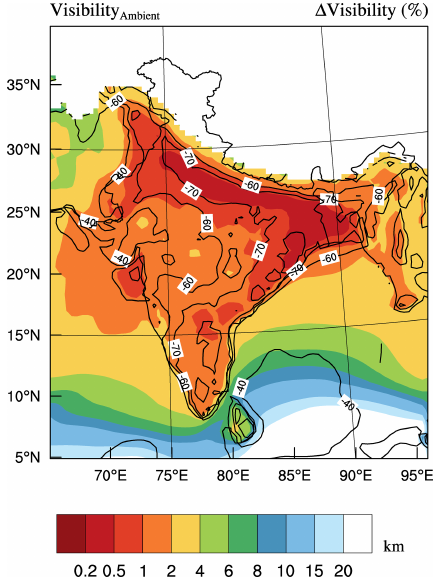
Figure 11. Spatial variation in mean visibility over the Indian re- gion for ambient feedback simulation. The percentage variation in visibility changes due to hygroscopic growth with respect to visibil- ity due to dry aerosols is given as line